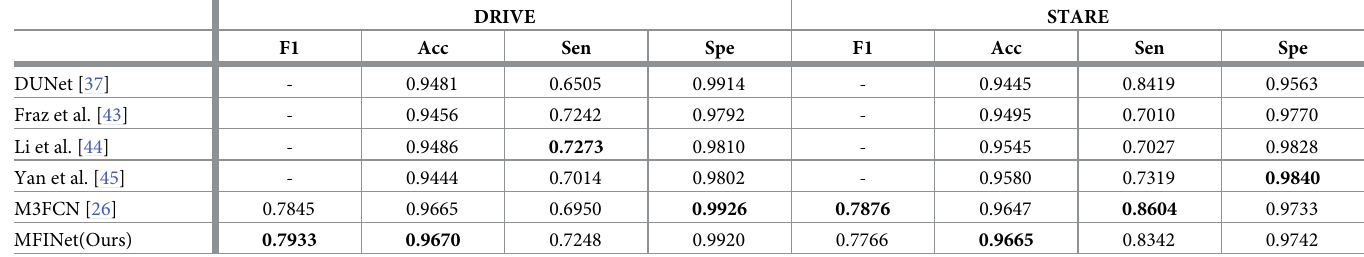
Table 8. Results of cross-testing on DRIVE and STARE